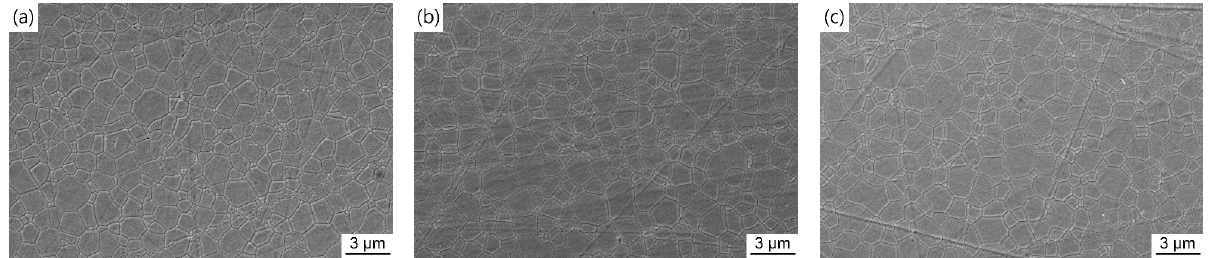
Fig. 4 FESEM micrographs of the 1.0 at% RE:TGG ceramics pre-sintered at 1500 ℃ for 3 h in air and HIP-ed at 1500 ℃ for 3 h: (a) Pr:TGG, (b) Tm:TGG, and (c)